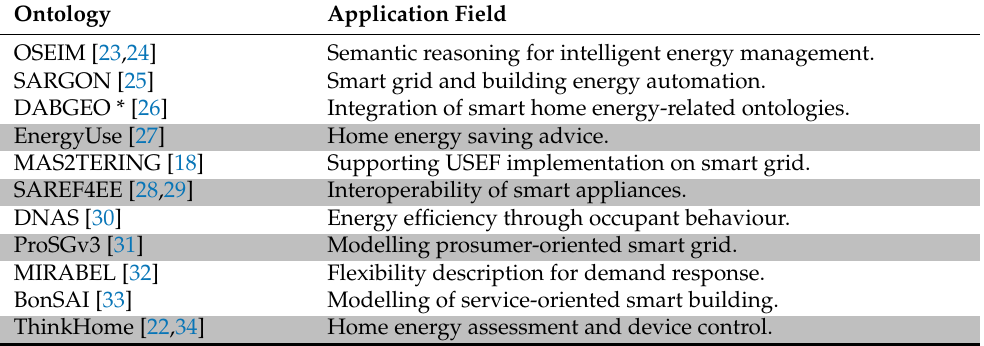
Table 1. Ontology